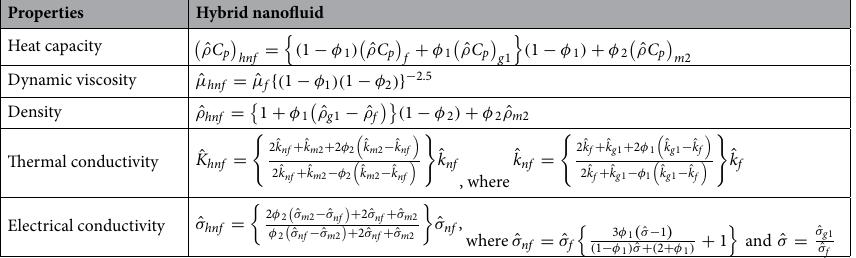
Table 1. Thermophysical properties and relations of hybrid nanofluids 56,57 .